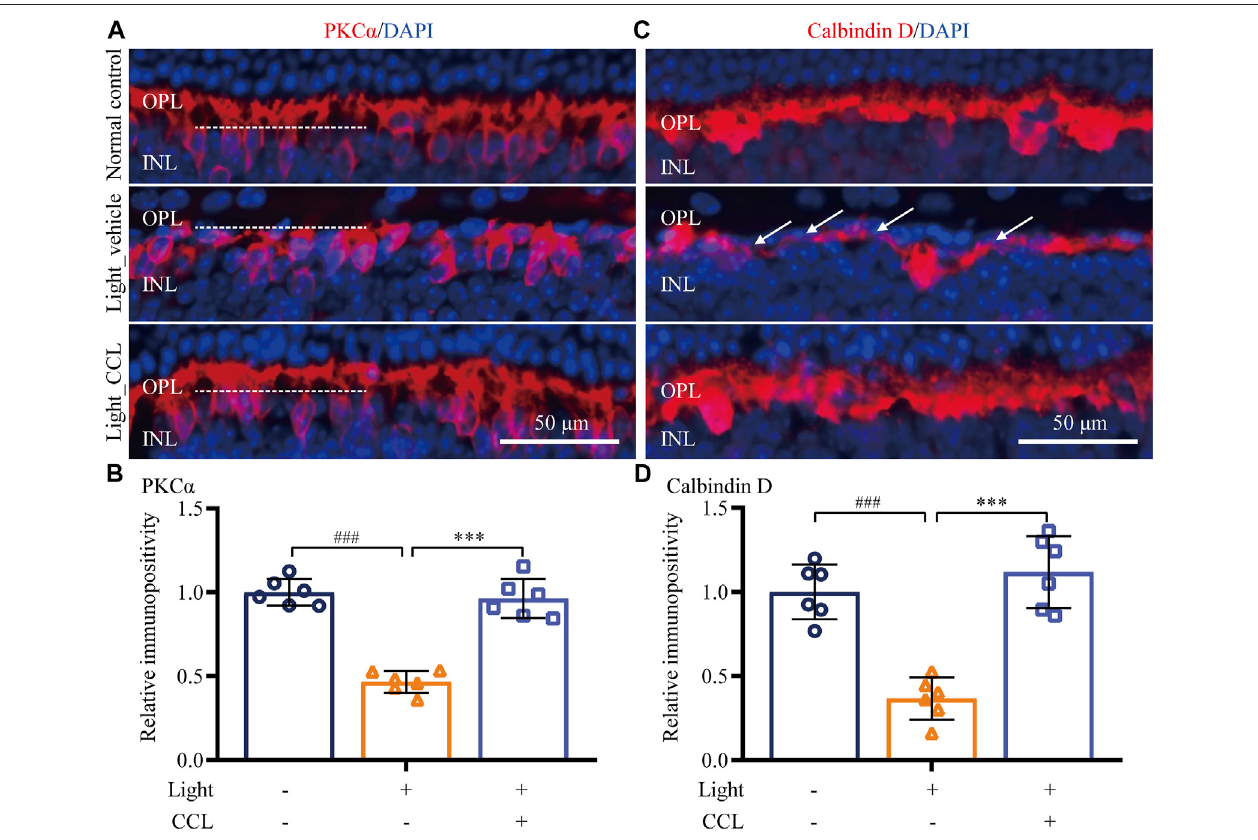
FIGURE6| CCLattenuatesthemorphologicalimpairmentofbipolarandhorizontalcellsinthelight-exposedretinas.IHCwasperformedtoexaminetheexpression of PKC α (in red) and calbindin D (in red) in the retina. Counterstaining of DAPI (in blue) was performed. The immunopositivity of PKC α and calbindin D in OPL was quanti fi ed by ImageJ. (A) Representative micrographs showing the expression of PKC α in the retina. (B) The relative fold change in the immunopositivity of PKC α was plotted against that from Normal control. (C) Representative micrographs showing the expression of calbindin D in the retina. (D) The relative fold change in the immunopositivityofcalbindinDwasplottedagainstthatfromNormalcontrol.INL,innernuclearlayer;OPL,outerplexiformlayer.Scalebar,50 μ m.Datawereexpressed as mean ± SD (n = 6 per group). ### Compared to Normal control, p < 0.001; *** compared to Light_vehicle, p < 0.001.